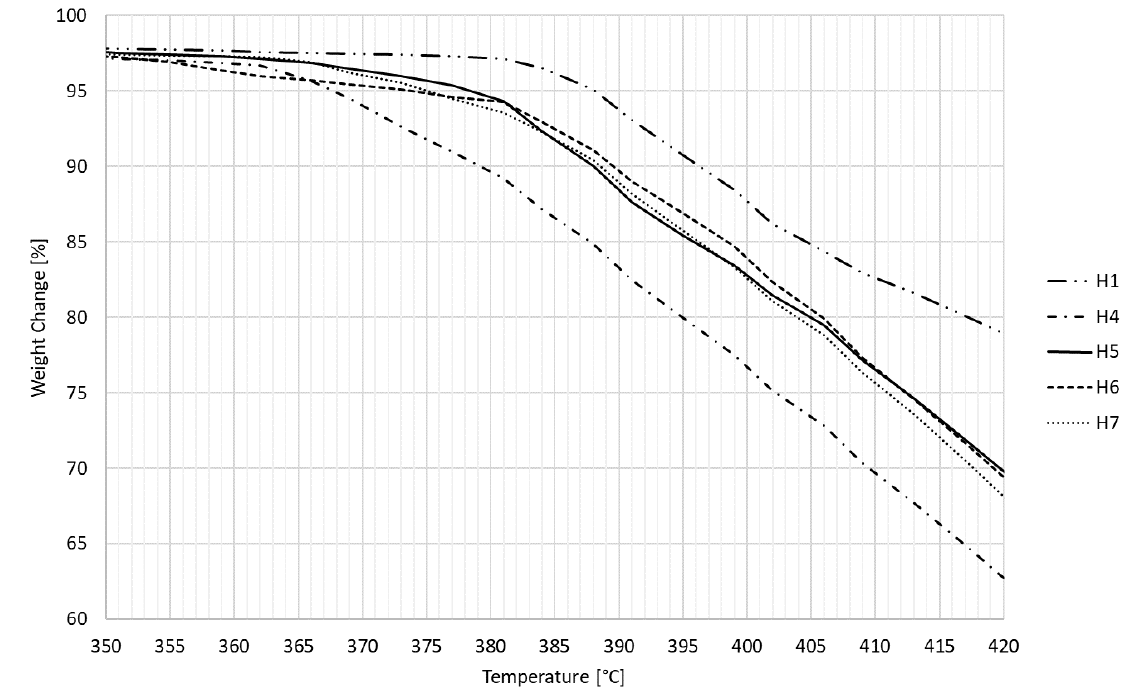
Figure 12. Degradation curves of nonmodified and modified HDPE specimens in detail.